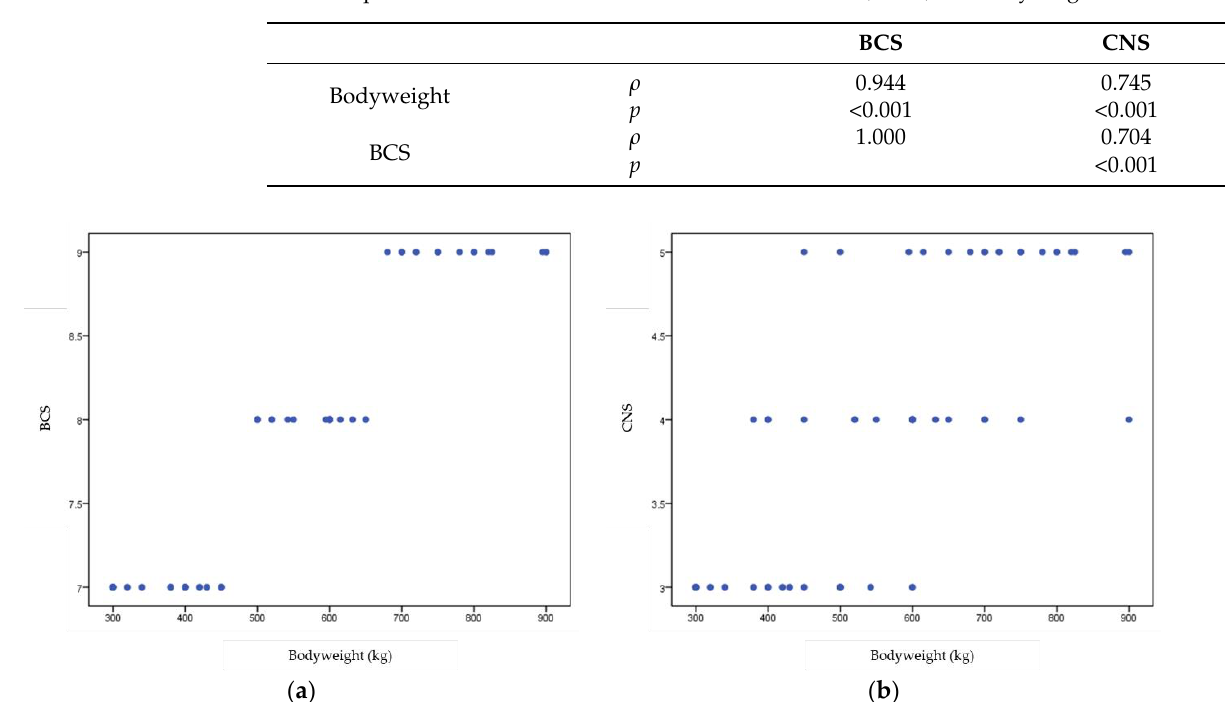
Table 7. Spearman correlation rank coefficients between BCS, CNS, and bodyweight.